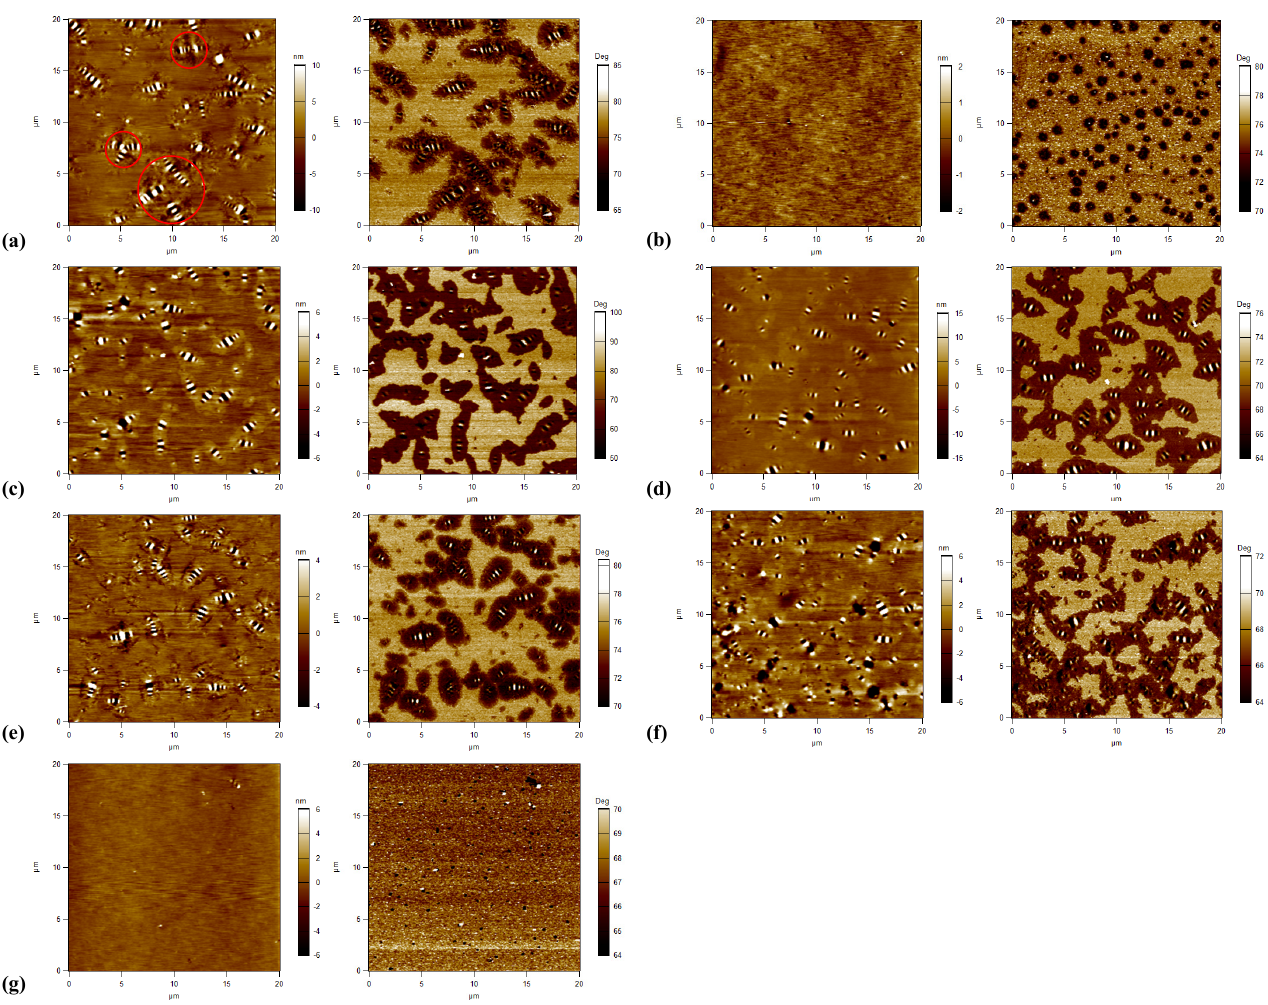
Figure 9. Topography ( left ) and phase ( right ) images of tested asphalt binders: ( a ) A; ( b ) B; ( c ) C; ( d ) D; ( e ) E; ( f ) F; ( g )